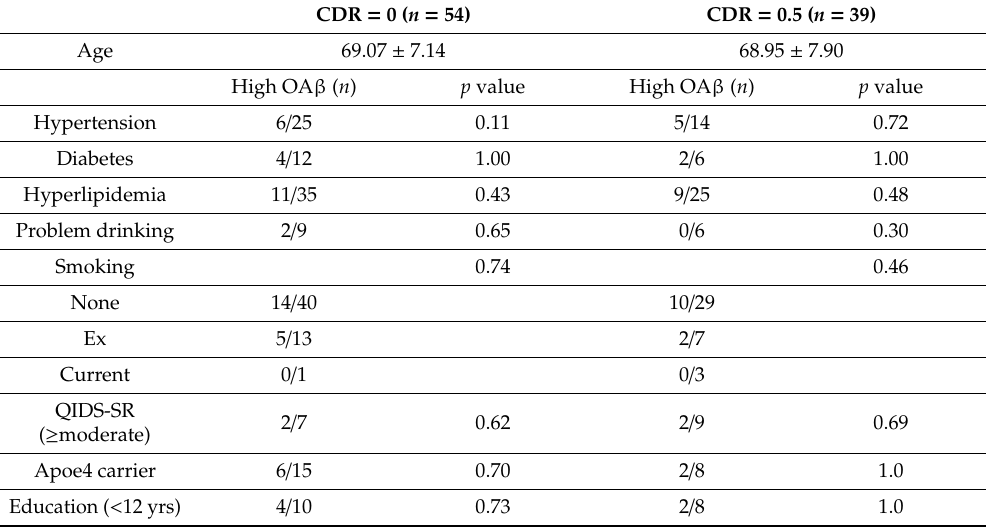
Table 2. Clinical variables of population with CDR = 0 and CDR =